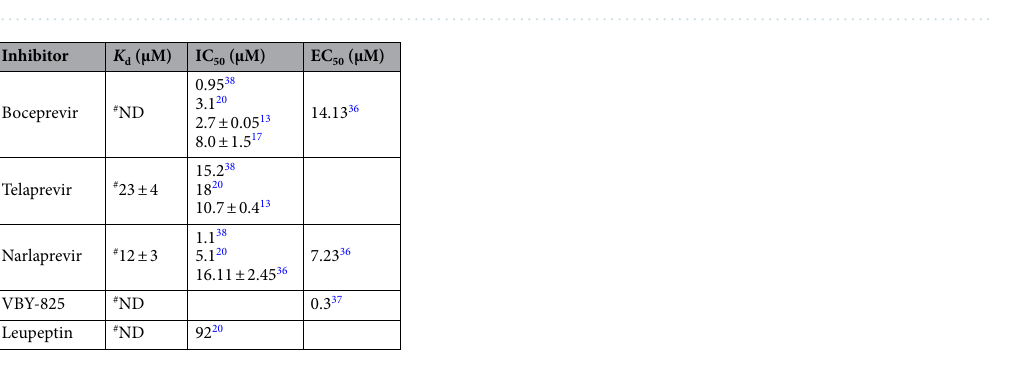
Figure 2. The equilibrium dissociation constants between ( A ) M pro -telaprevir (23 ± 4 μM) and ( B ) M pro - narlaprevir (12 ± 3 μM) were determined by thermophoretic experiments titrated against fluorescently labeled M pro . Dissociation curves were fit to the data to calculate the K d s. Data shown are the mean ± SD, n = 3. For boceprevir, the binding experiment was not successful due to the precipitation of the ligand in the assay buffer (30 mM sodium phosphate pH 8.0, 200 mM NaCl, 1 mM DTT). The precipitation led to turbidity and a non- uniform fluorescent signal.